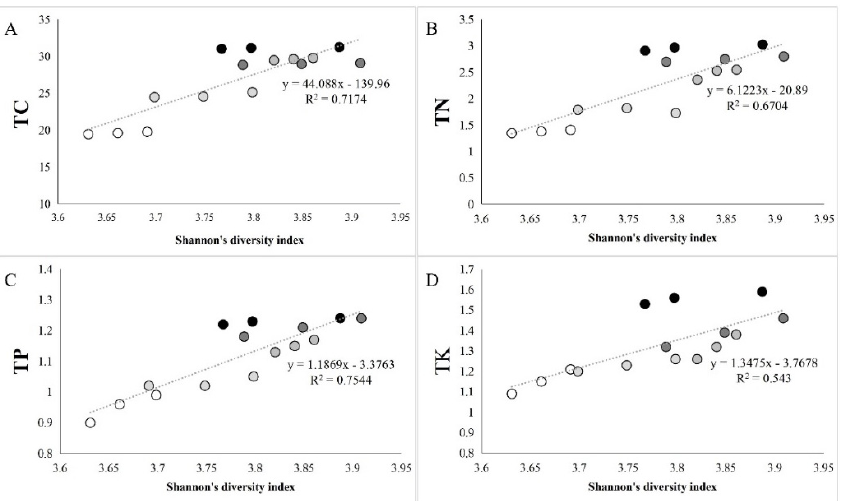
Figure 4. Relationships between the soil nutrients and the diversity index of the microbe in the roof ecosystem. R-squared (R 2 ) and p -values were estimated from a linear regression model, and the best-fit line is shown on the graph. Biochar treatments were: CK, no biochar ( ); 5%SB, soil and 5% biochar ( ); 10%SB, soil and 10% biochar ( ); 15%SB, soil and 15% biochar ( ) and 20%SB, soil and 20% biochar ( ). ( A – D ) Total carbon (g kg − 1 ), total nitrogen (g kg − 1 ), total phosphorus (g kg − 1 ) and total potassium (g kg − 1 ) of the roof soil, respectively.